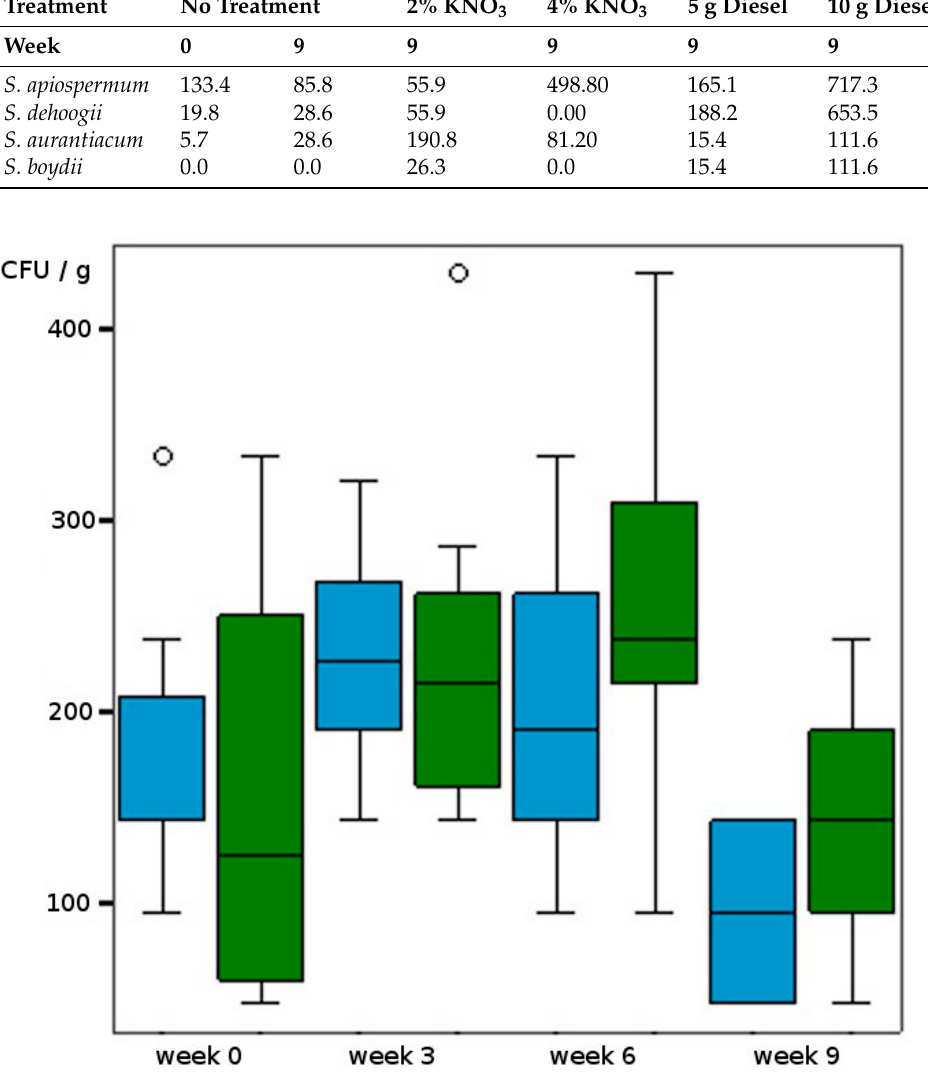
Figure 1. Alteration of CFU/g soil (dw) at different incubation temperatures (blue: 18 ◦ C, green: 25 ◦ C, circles: outliers).